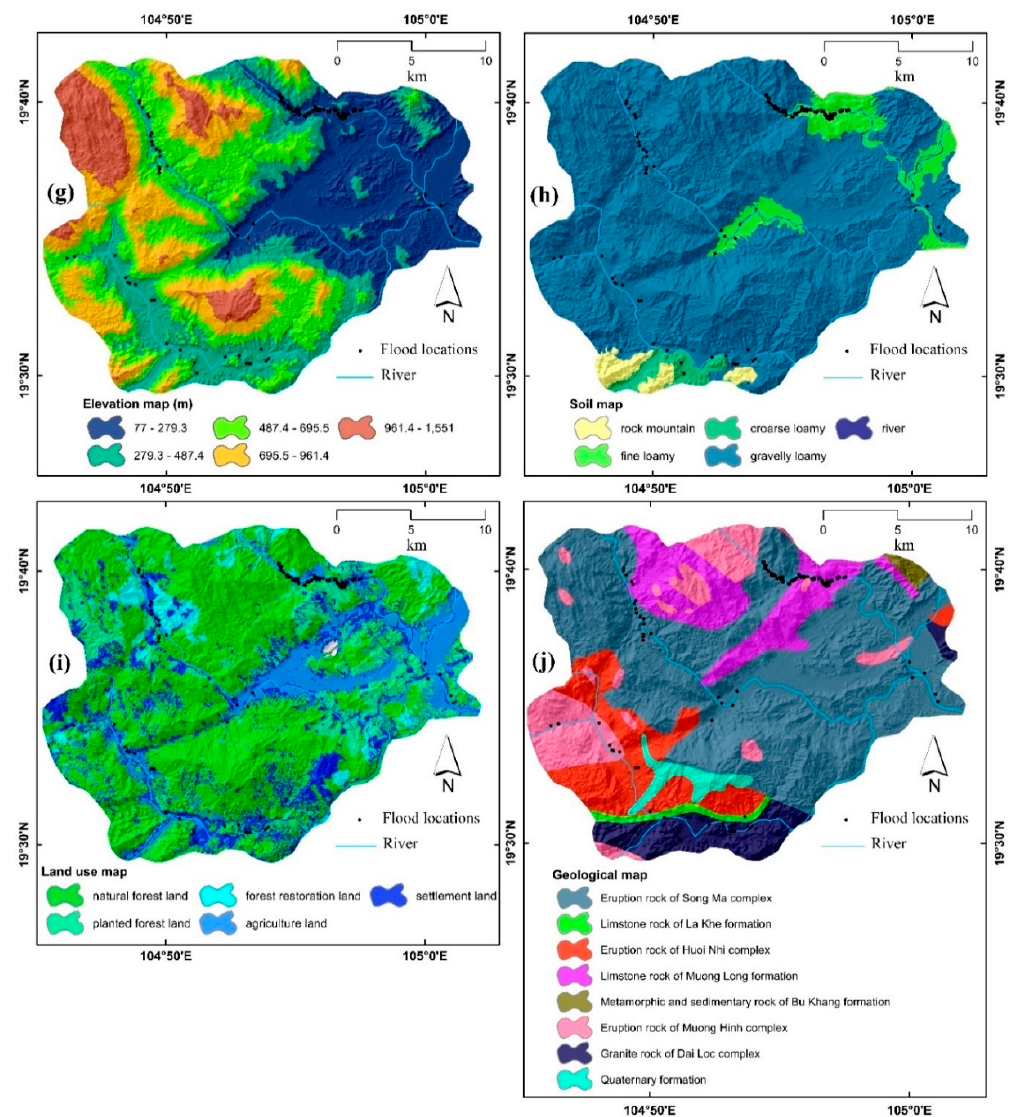
Figure 2. Maps of flash flood conditioning factors: ( a ) slope, ( b ) aspect, ( c ) curvature, ( d ) river density, ( e ) flow direction, ( f ) distance from rivers, ( g ) elevation, ( h ) soil, ( i ) land use, and ( j ) geology.